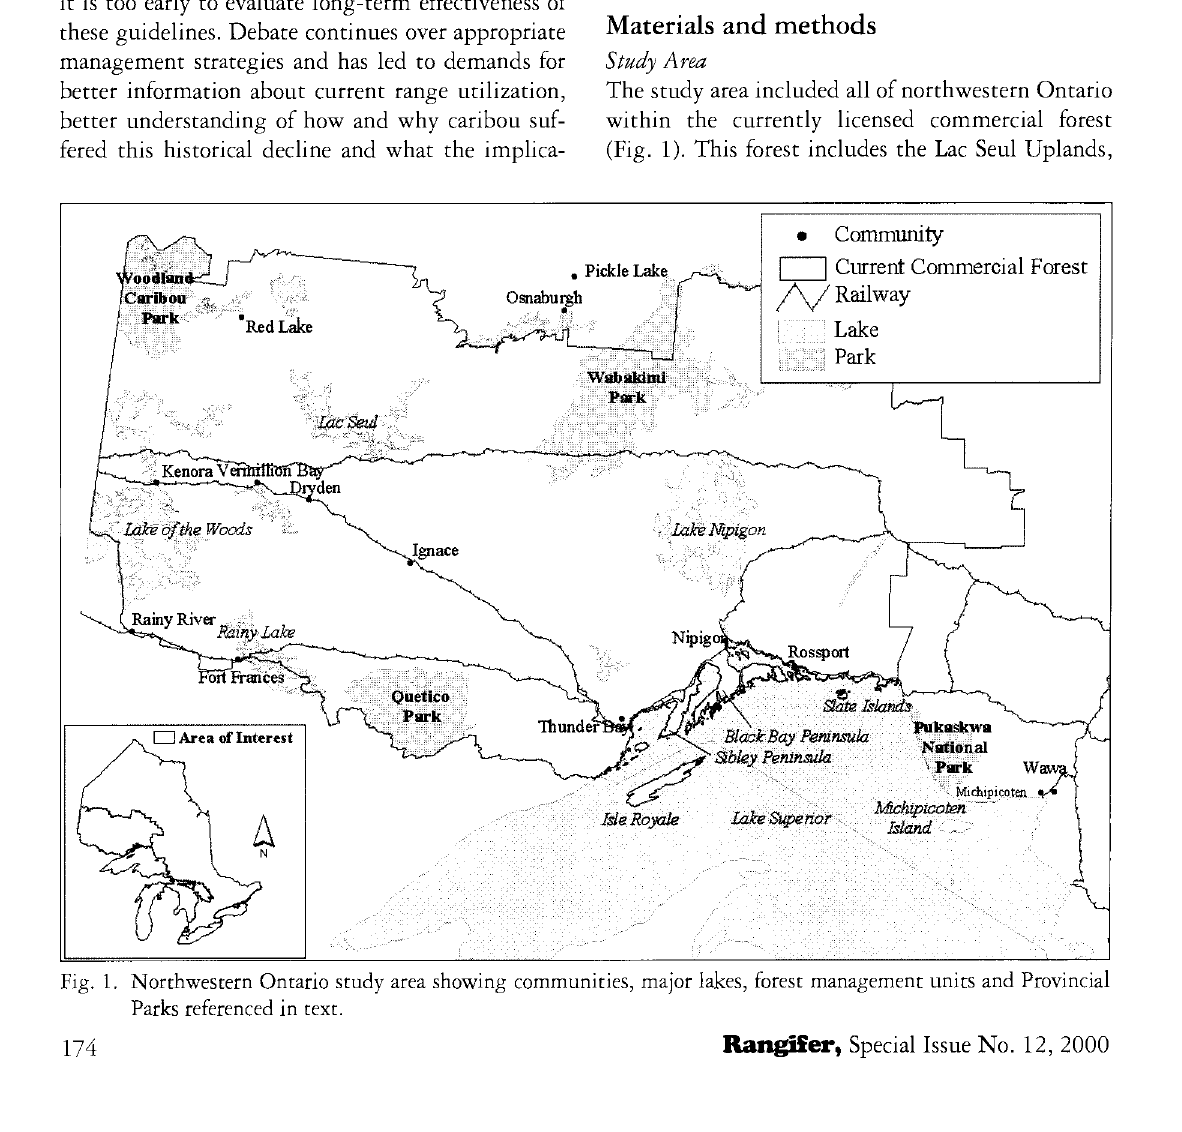
Fig. 1. Northwestern Ontario study area showing communities, major lakes, forest management units and Provincial Parks referenced in